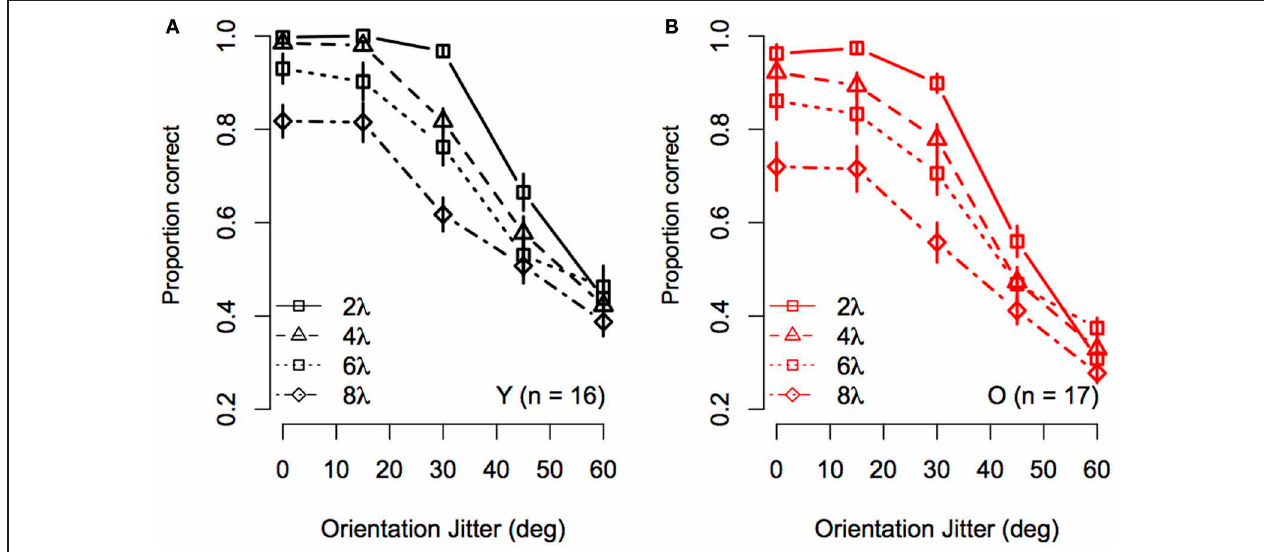
FIGURE 3 | Experiment 1 results: Effect of inter-element spacing on contour discrimination accuracy is shown as a function of orientation jitter for younger subjects (A) and older subjects (B). Different symbols show accuracy for 2 λ to 8 λ conditions separately (see legend). Error bars represent ± 1SEM.